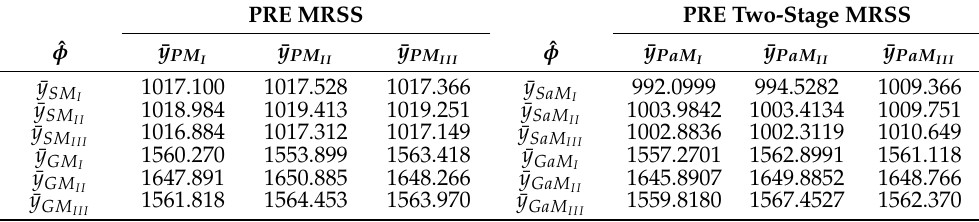
Table 6. PRE values for ( A 2 , B 2 )